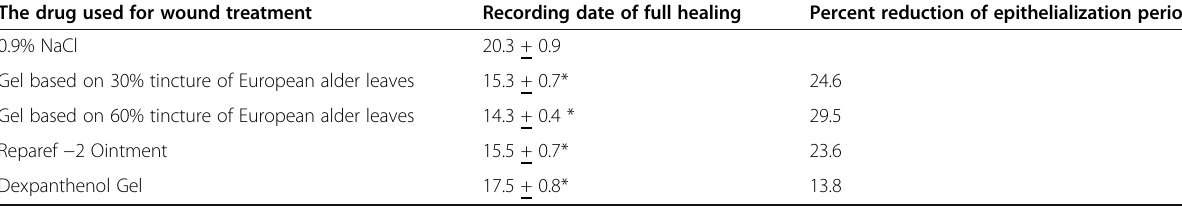
Table 1 The period of complete healing in rats of different groups The drug used for wound treatment Recording date of full healing Percent reduction of epithelialization periods 0.9% NaCl 20.3 + 0.9 Gel based on 30% tincture of European alder leaves Gel based on 60% tincture of European alder leaves Reparef − 2 Ointment Dexpanthenol Gel *- significantly different compared to the control group p <0.05 As observed from the table the gel based on 60% tincture of Alnus glutinosa (L) leaves has the highest healing